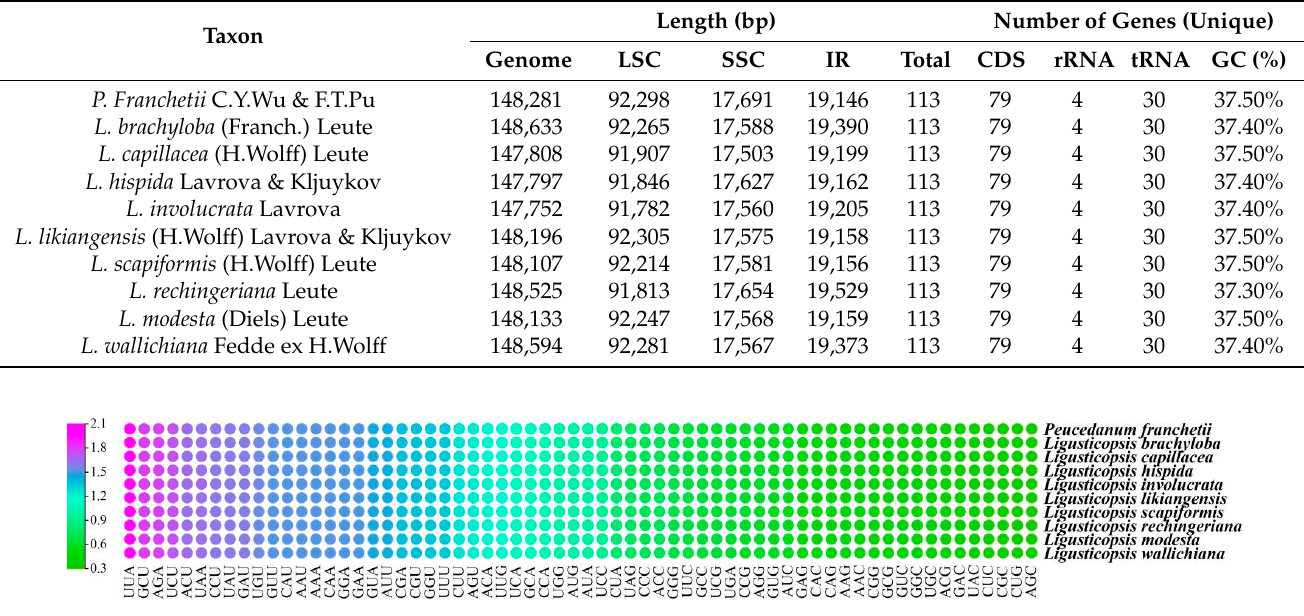
picked out: petD (one site; only identified in L. involucrata ) (Figure 4B). Moreover, the